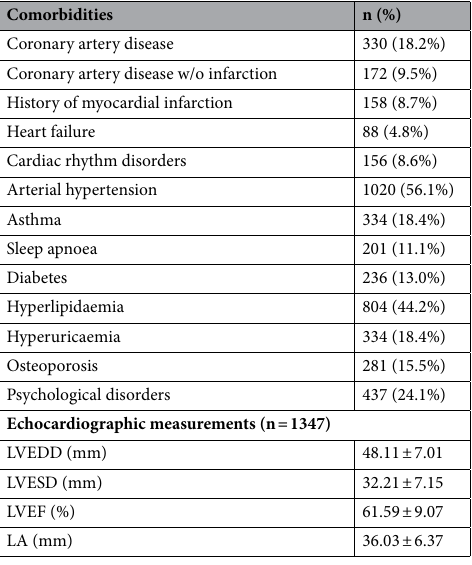
Table 3. Comorbidities of the total study population and echocardiographic measurements at visit 1. The echocardiographic measures are given as mean values and standard deviations; the number of patients with impairments is given in the Results. LVEDD = left ventricular end-diastolic diameter; LVESD = left ventricular end-systolic diameter; LVEF = left ventricular ejection fraction, LA = left atrial diameter.